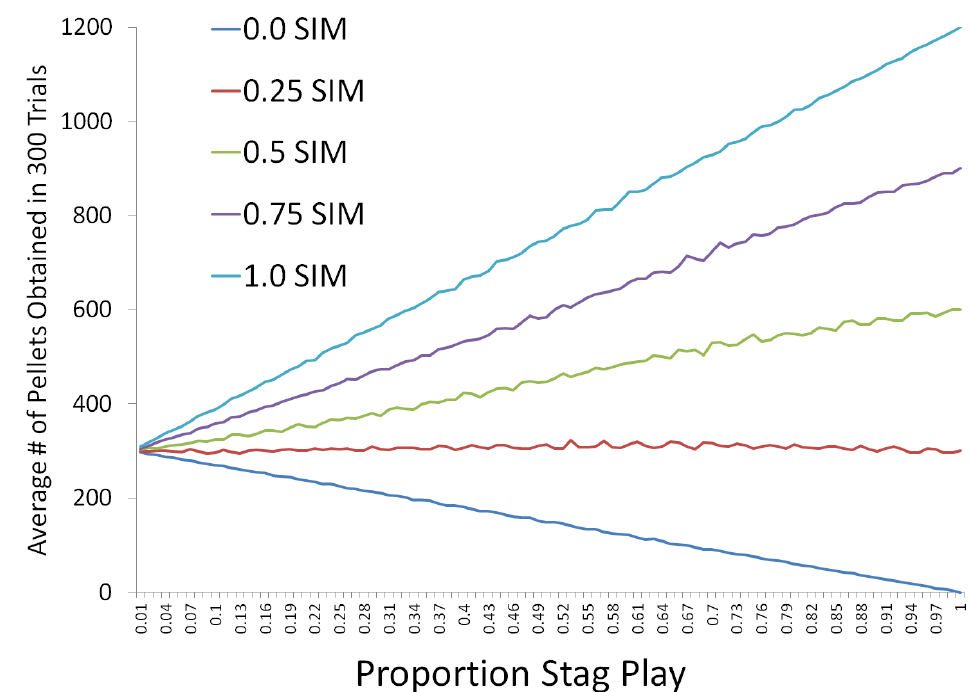
Figure 4. Results of modeling the reward outcomes for different play strategies against different SIMs. 100 hypothetical players each completed 300 trials at each of 100 probabilities of choosing Stag against each SIM that was used with the monkeys (excluding TfT). The mean number of pellets obtained by those 100 players is shown for each probability level for selecting Stag by those